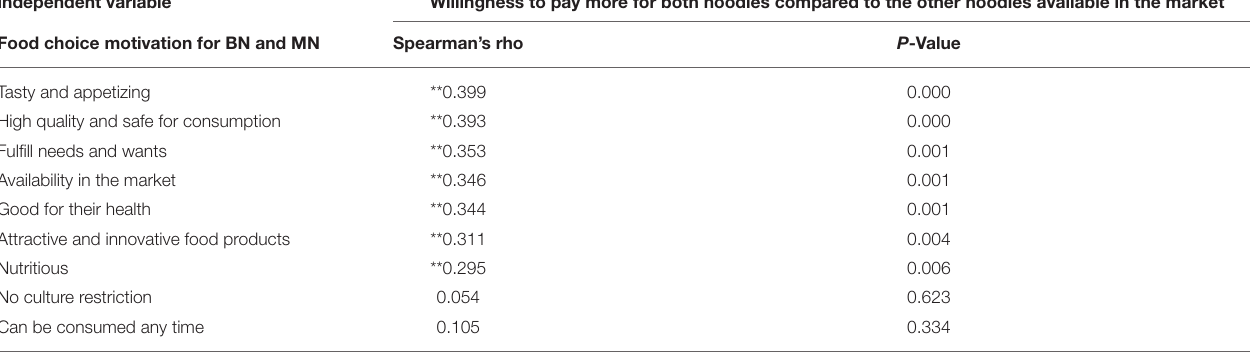
TABLE 5 | Correlation between respondents’ willingness to pay more for BN and MN and their food choice motivation. Independent variable Willingness to pay more for both noodles compared to the other noodles available in the